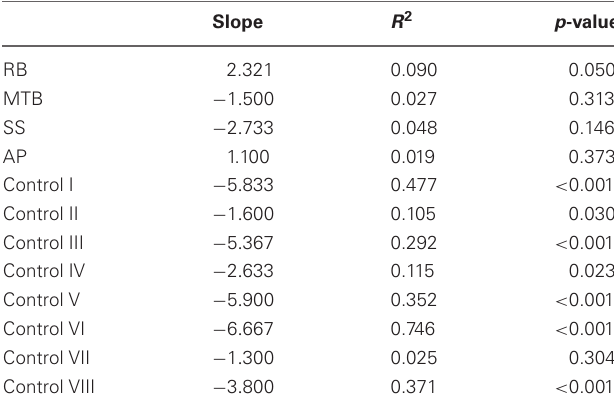
Table 2C | Regression values for Delayed Open-loop